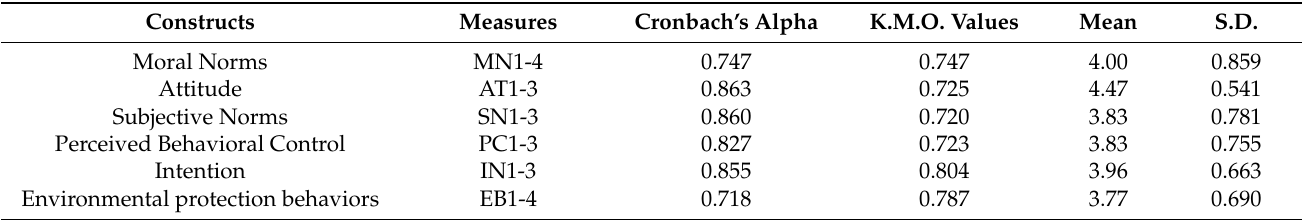
Table 4. Summary of latent variables for Model ETPB.